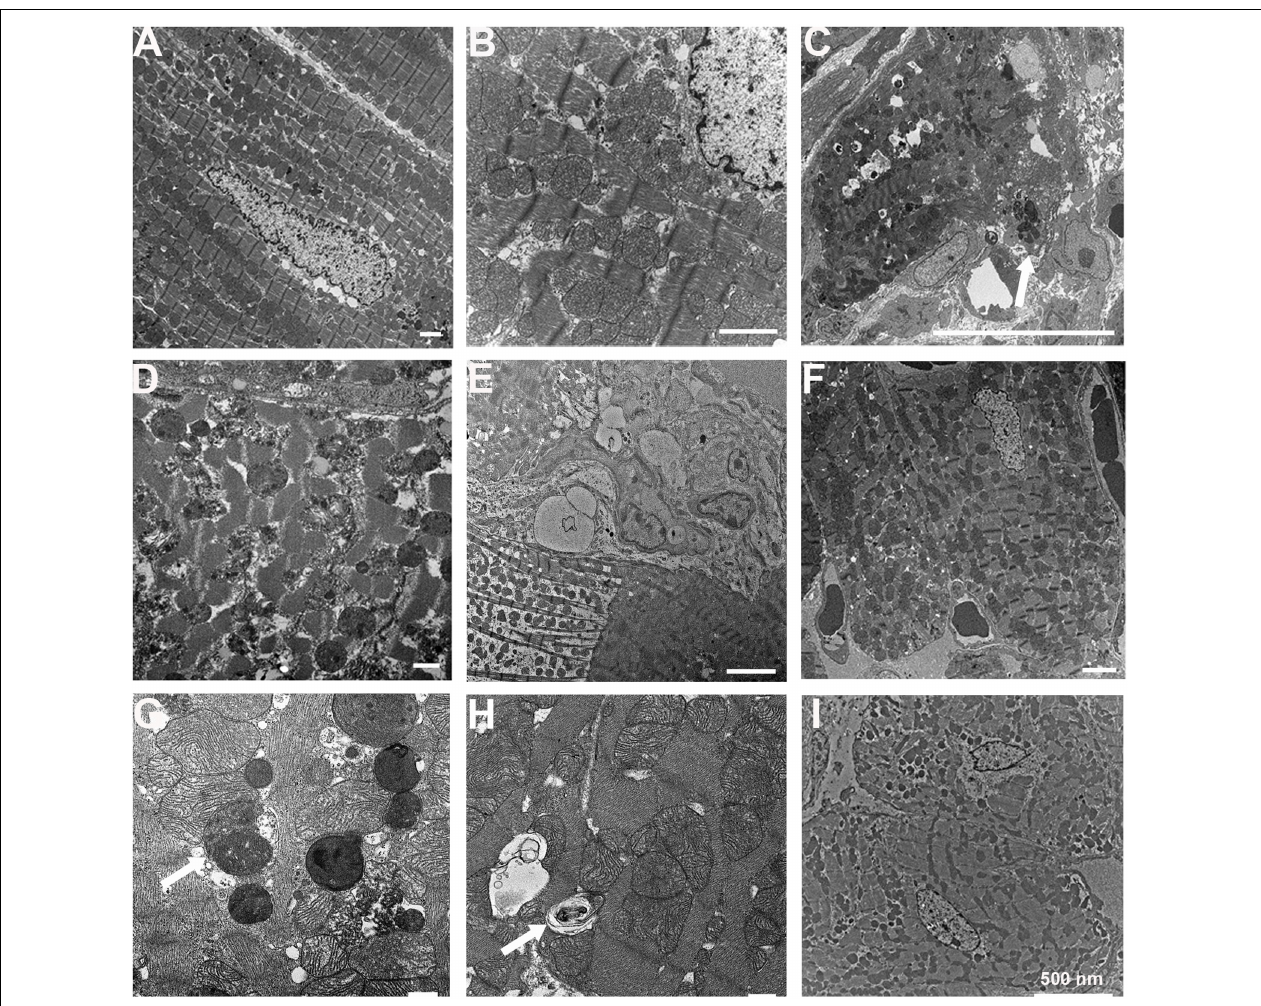
FIGURE 3 | Aliskiren treatment improves cardiac ultrastructure and upregulates the autophagosomes in cardiomyocytes of MI mice by transmission electron microscopy. (A) Cardiomyocytes in the sham-operated mice. (B) The normal cardiomyocyte was shown at higher magnification. (C) The damaged cardiomyocytes in MI mice showed apoptotic bodies (arrow). (D) The damaged cardiomyocyte was shown at higher magnification. (E) Fibroblasts were shown in the infarcted and marginal myocardium at 14D following myocardial infarction. (F) Aliskiren improved the ultrastructure of cardiomyocytes. (G) Accumulation of autophagosomes in cardiomyocytes in aliskiren-treated mice. The arrow denotes the autophagosome. (H) Late autophagosomes contain concentric lamellar inclusions and cytoplasmatic contents (arrow). (I) Heart tissues from aliskiren treatment at MI after 14 days. Bar: 500 nm. Each of the experiments was repeated three